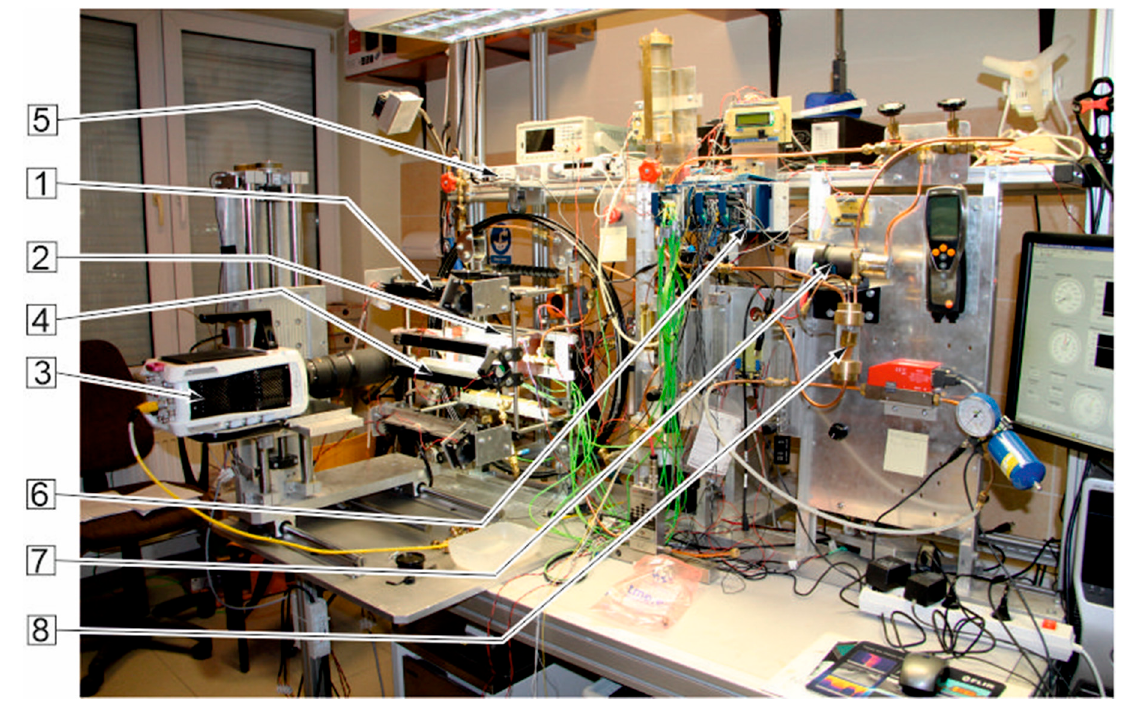
Figure 4. General view of the experimental stand: 1—type (a) illuminator, 2—b type (b) illuminator, 3—high speed camera, 4—measurement module with the mini-channel, 5—DC power supply [high-current TDK Lambda], 6—facility control unit [NI cDAQ-9178 chassis], 7—gear precision pump [Tuthill DGS 38 PP], 8—filter.